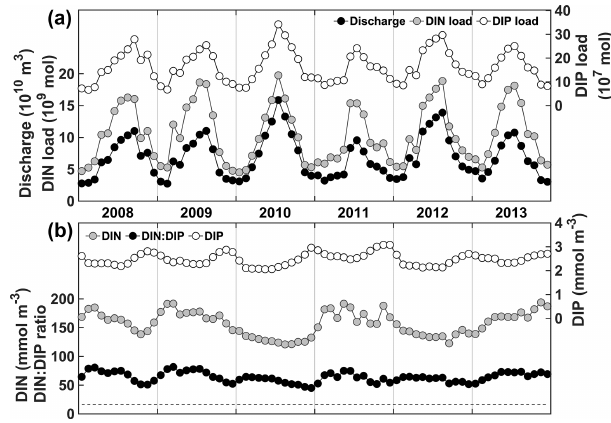
Figure 2. Changjiang river forcing data. (a) Freshwater discharge from the Datong hydrological station (Fig. 1) and nutrient loads. (b) Nutrient concentrations and